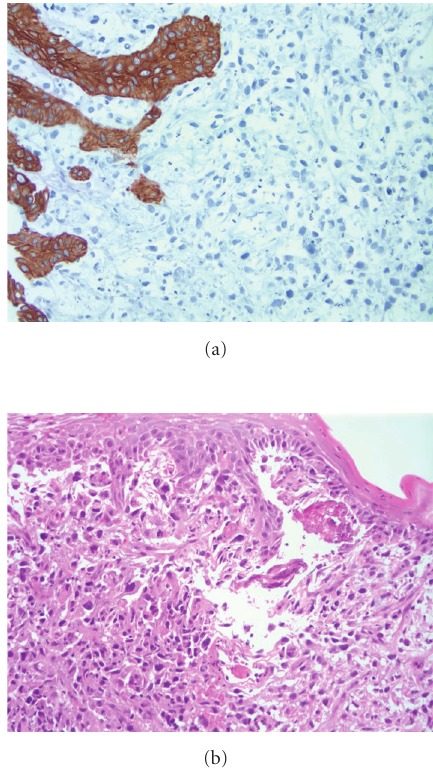
Figure 2: Pathology slide. (a) Tumor cells from the esophageal mass shown to be negative for pankeratin, with presence of actin being equivocal. (b) The submucosa of the esophagus contains mitotically active spindle cells and pleomorphic spindle cells with eosinophilic cytoplasm and focal areas containing eosinophilic stromal hyaline- like material, likely osteoid.